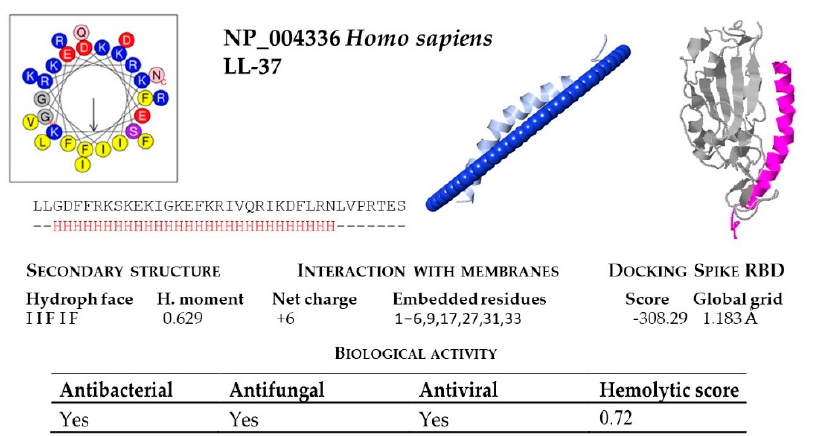
Figure 6. Bioinformatic analysis of human cathelicidin peptide LL-37. Net charge, secondary struc- ture, hydrophobicity of helixes, interaction with membranes and with the SARS-CoV-2 region binding